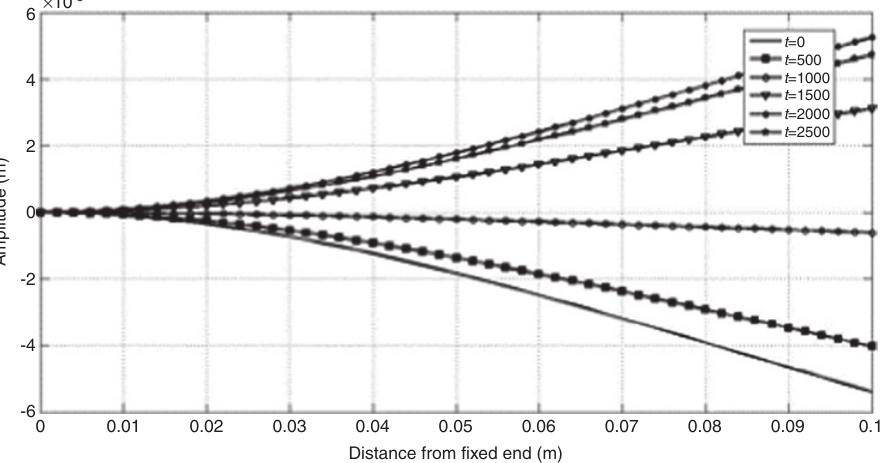
Figure 9: Vibrations of the first characteristic mode of the cantilever beam. Time, t , is in milliseconds.